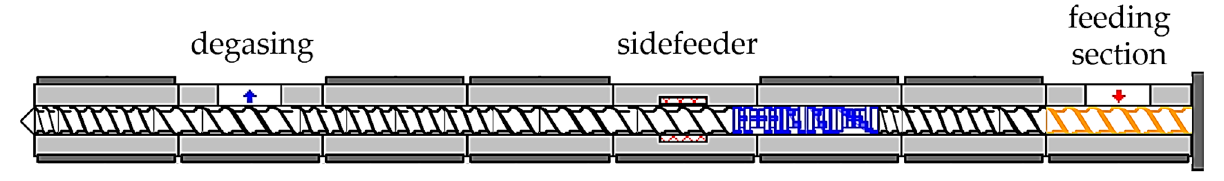
Figure 1. Configuration of the twin screws.